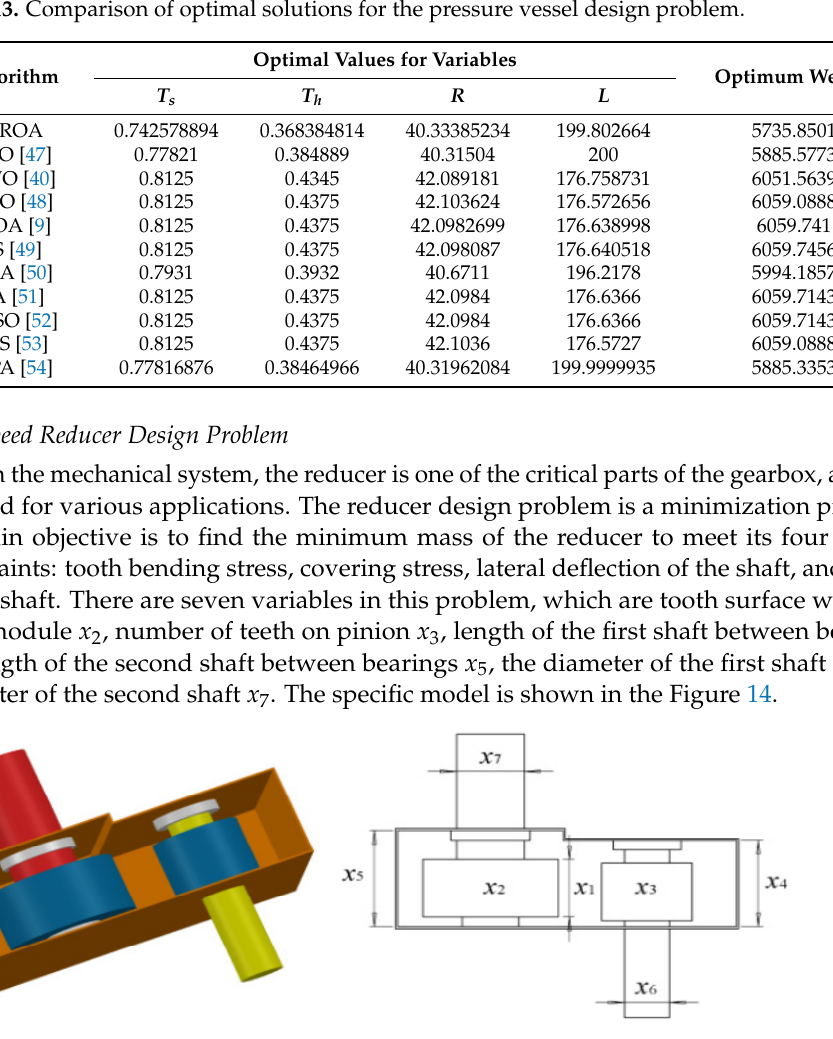
Figure 14. Model of speed reducer design.